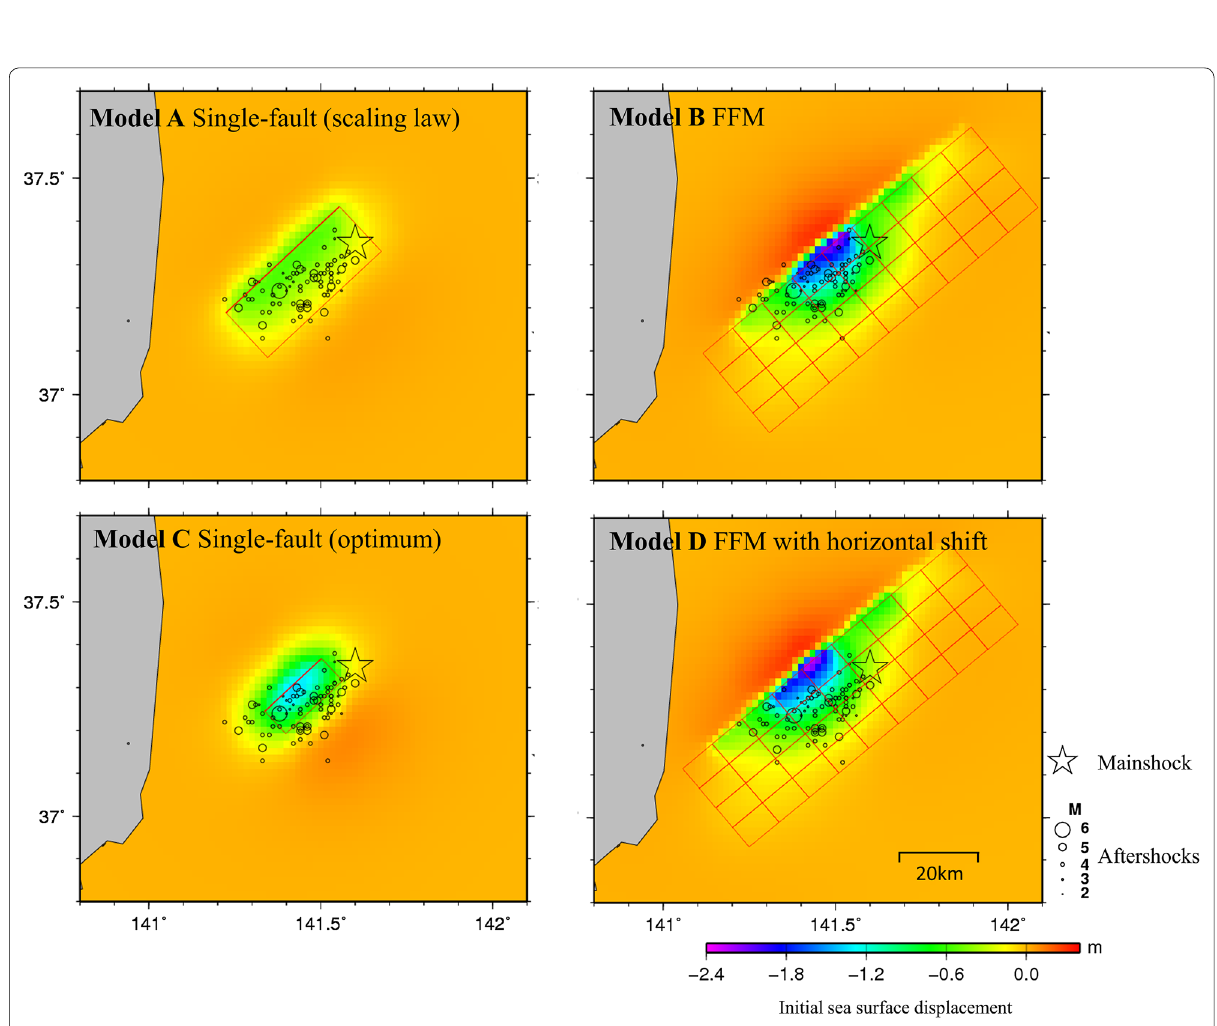
Fig. 3 Initial sea surface displacement of model A, B, C, and D. The red rectangle represents the surface projection of the fault plane onto the horizontal plane. The mainshock and the locations of the first hour of aftershocks were also shown. The mainshock was derived by JMA (2016a), and the aftershocks are by the Seismological Bulletin of Japan (http://www.data.jma.go.jp/svd/eqev/data/bulle tin/index